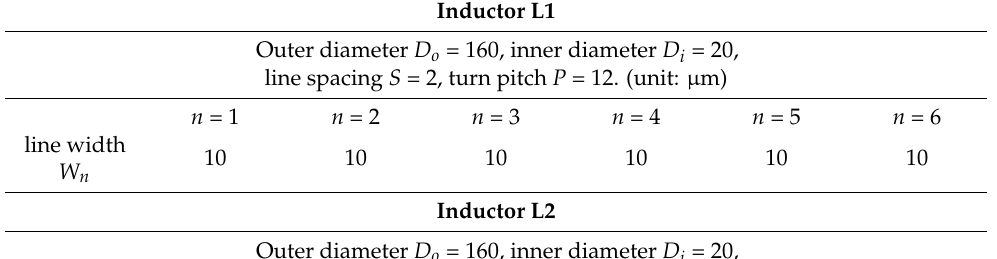
Outer diameter D o = 160, inner diameter D i = 20,